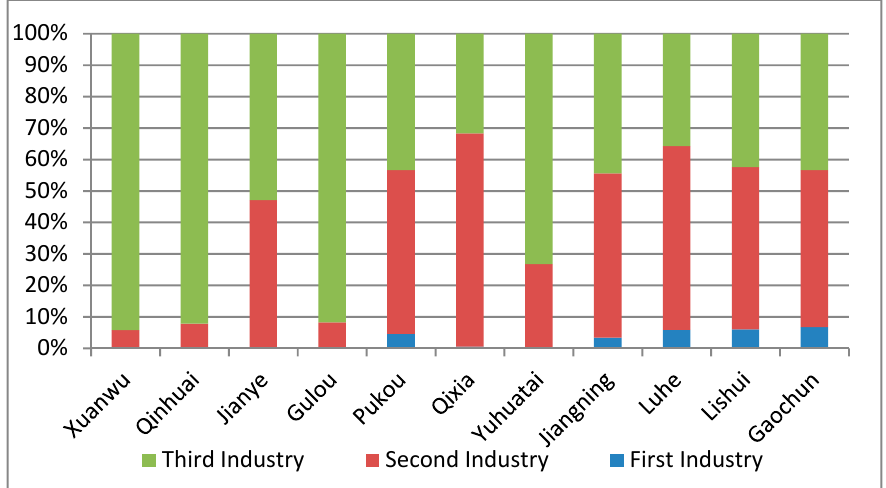
Figure 7. The industrial structure of each district in Nanjing.